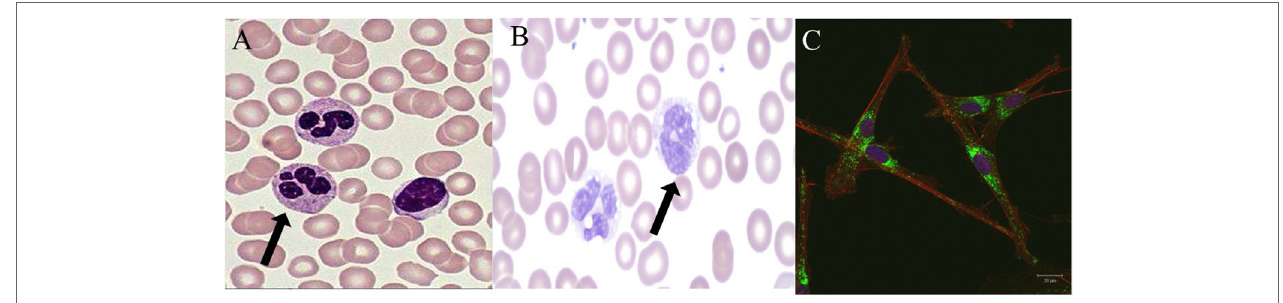
FigURe 1 | Normal and abnormal neutrophil morphology. (A) . Normal human neutrophils (arrow) with characteristic multi-lobed nucleus. Primary and secondary granules are visualized in the cytoplasm. (B) . Human neutrophils (arrow) from a patient with a mutation in CEBP- ε causing specific granule deficiency. Neutrophils have a characteristic bilobed nucleus and absence of specific granules in the cytoplasm. (C) . Human giant fused cytoplasmic granules in a patient with Chediak– Higashi syndrome. Electron microscopy at 20